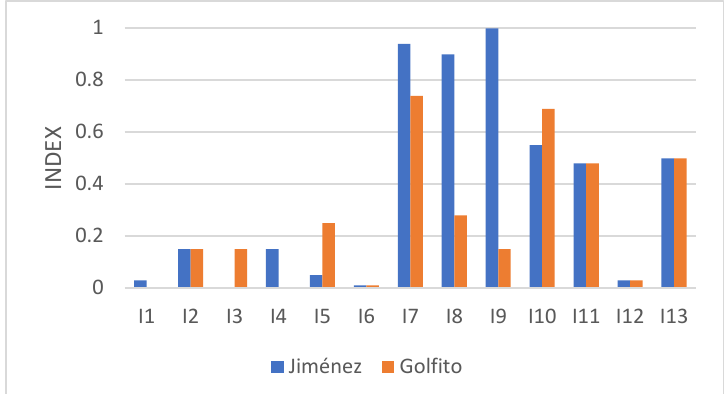
Figure 5. Values obtained by indicator for each alternative evaluated.